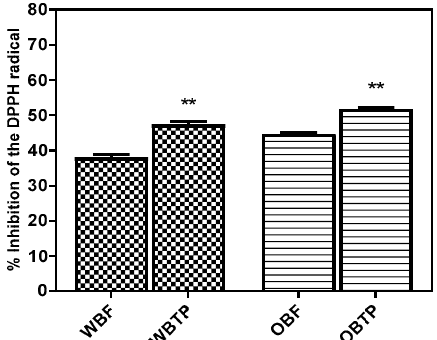
Figure 2. Antioxidant activity (DPPH free radical scavenging assay) of the wheat and oat bran extracts (fresh and thermally processed). The percentage inhibition ( I %) was calculated as [1 − (test sample absorbance / blank sample absorbance)] × 100. Values are expressed as mean values ± SD, I %, n = 3, and are followed by different symbols (**) indicating significant differences ( p < 0.05) between samples (Student’s t -test ( p = 0.05); GraphPad Prism Version 8.0.1, Graph Pad Software, Inc., San Diego, CA, United States).